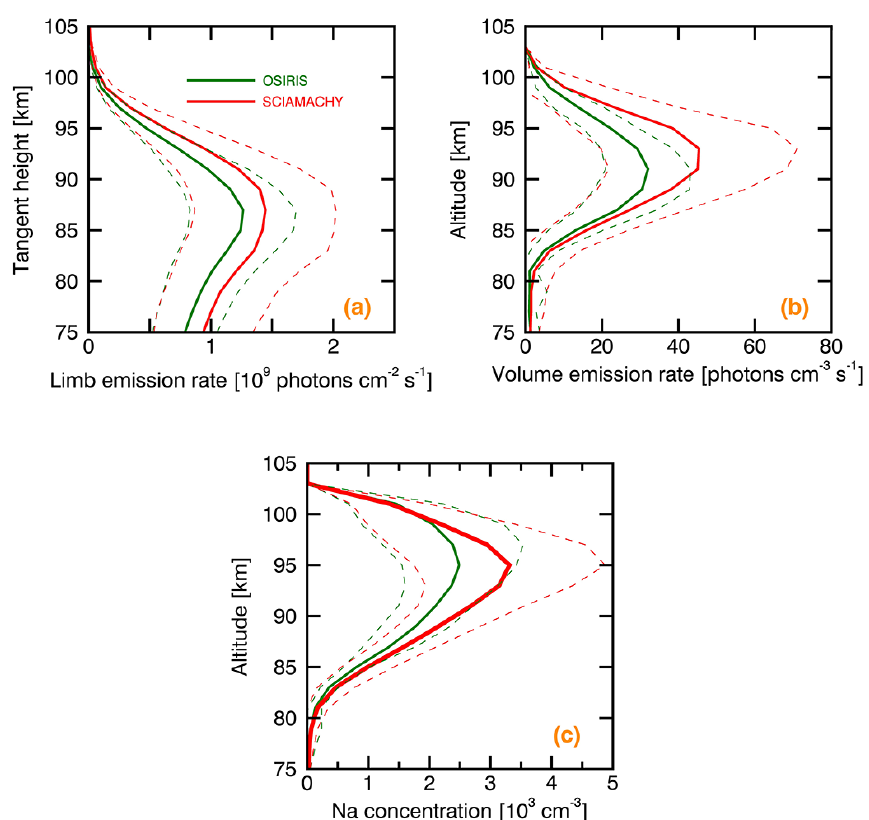
Figure 10. Comparison of mean LER profiles (a) , VER profiles (b) , and sodium concentration profiles (c) of SCIAMACHY (red) and OSIRIS (green) data. To obtain those profiles, we averaged over all available, i.e., 34 monthly averaged Na profiles and 67 LER profiles. The dashed lines show the standard deviation of the LER, VER and sodium concentration profiles of the corresponding altitude.